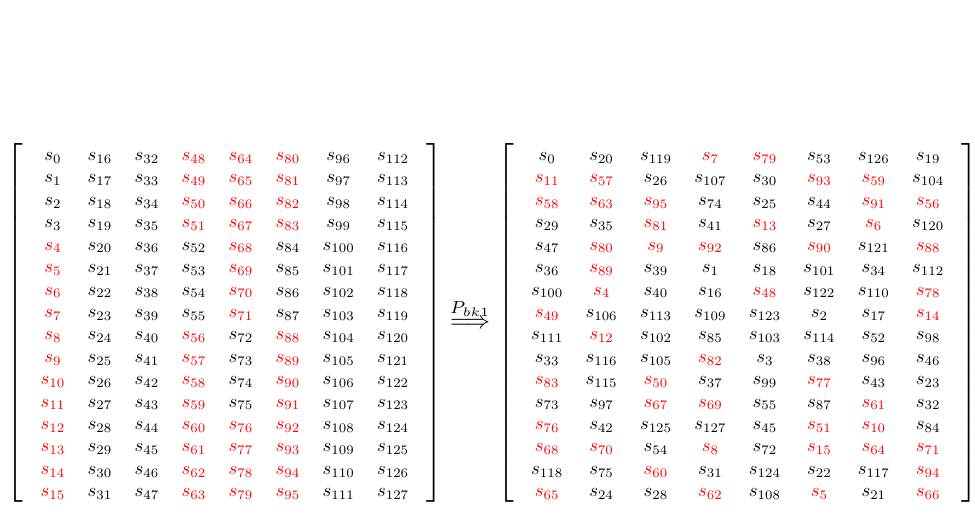
Figure 13: The 48 active bits after bit permutation in the second round, marked in red.